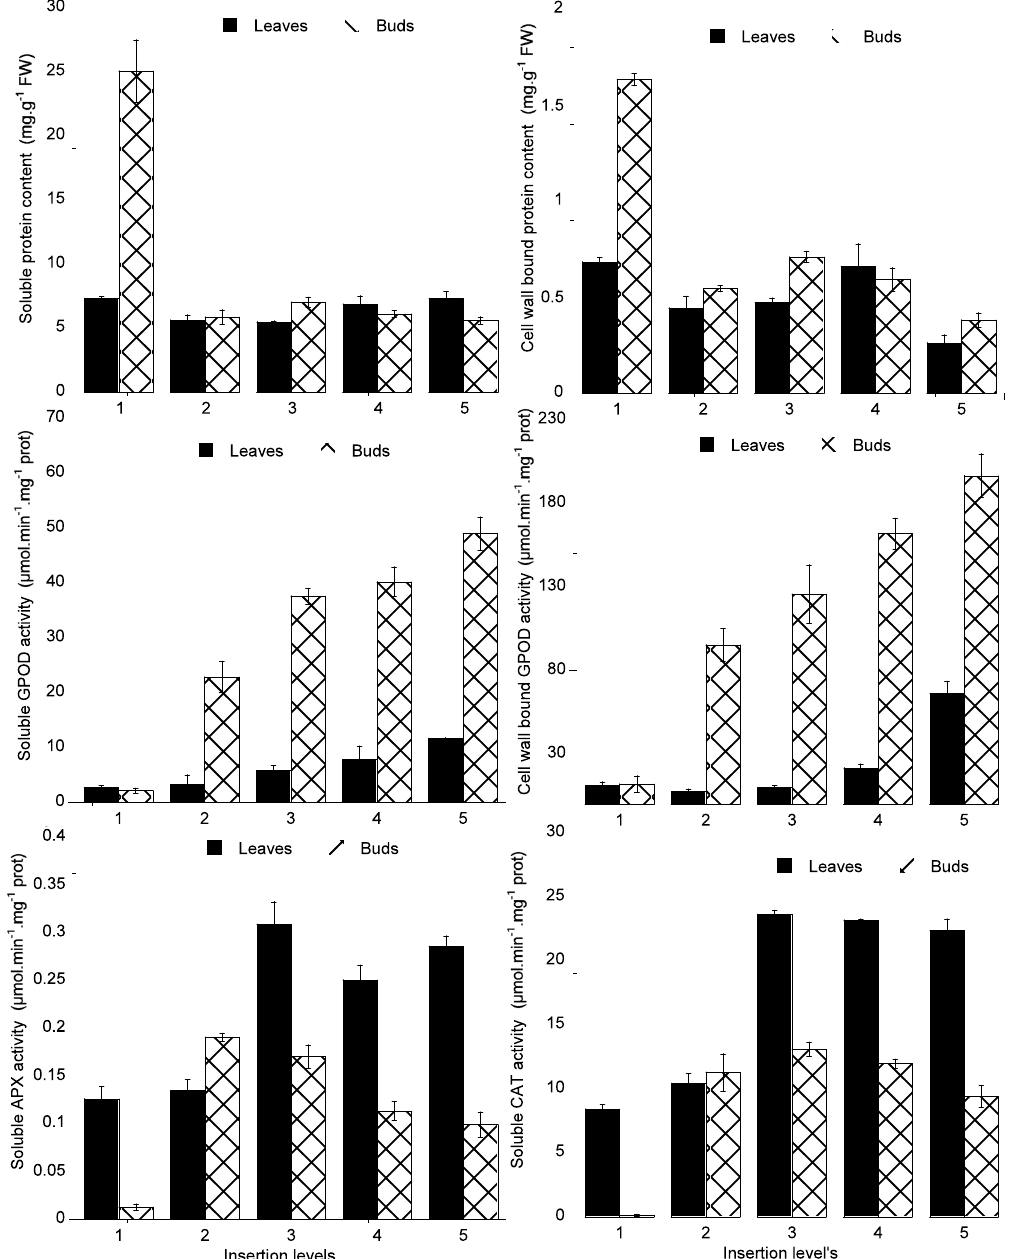
Fig. 4: Changes in protein (soluble and CWB) content and H 2 O 2 scavenging enzyme specific activities in flower buds and leaves from shoot top (first insertion level, first node) to the fifth node below the apex (insertion level 5). Bars indicate the standard error (mean+/- S.E.,